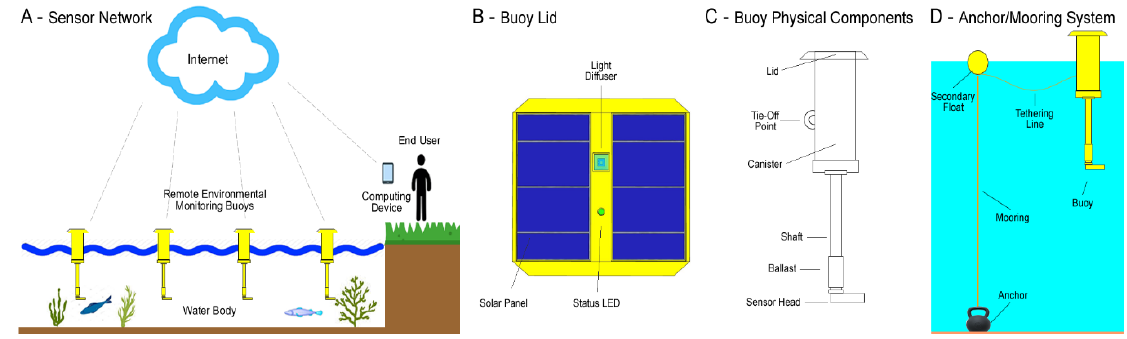
Figure 7. The remote aquatic environmental monitoring system.